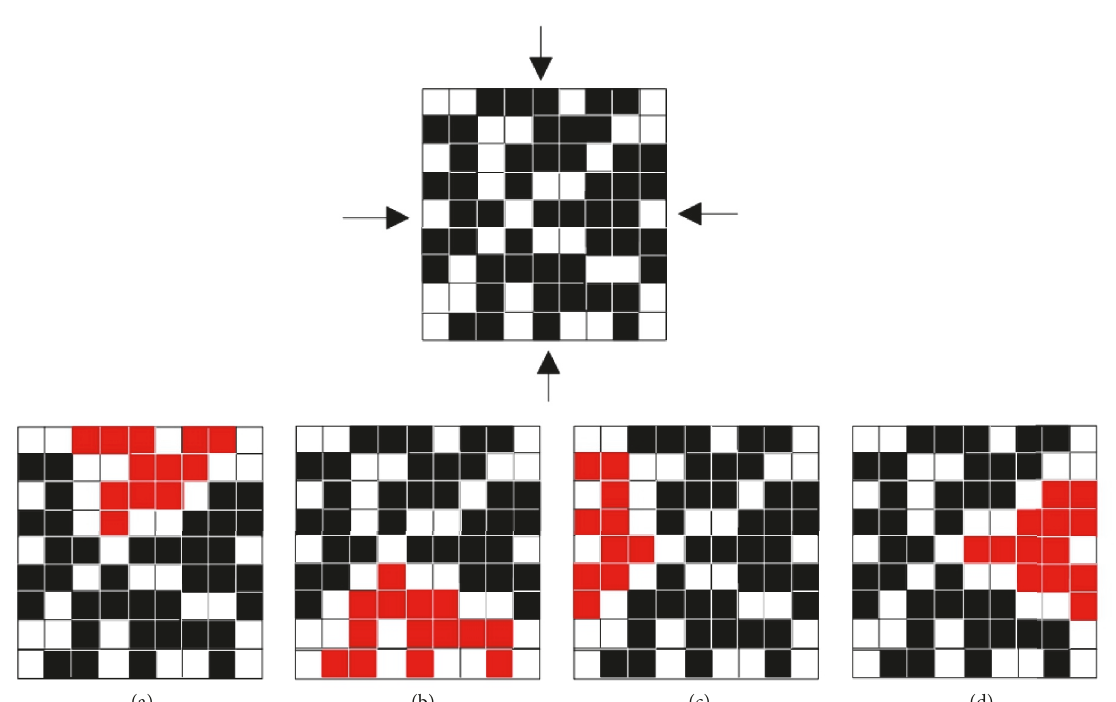
Figure 7: The Succolarity analysis approach. (a) From top to the bottom (t2b). (b) From bottom to the top (b2t). (c) From left to right (l2r). (d) From right to the left